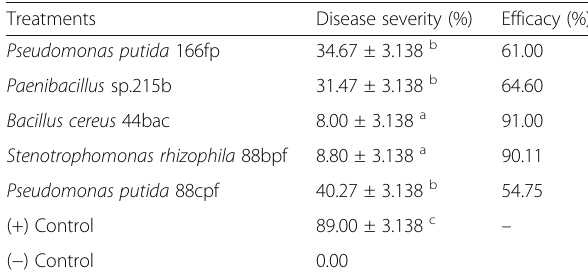
Table 2 Effect of some bacterial strains against the infection by Sclerotium rolfsii on turfgrass